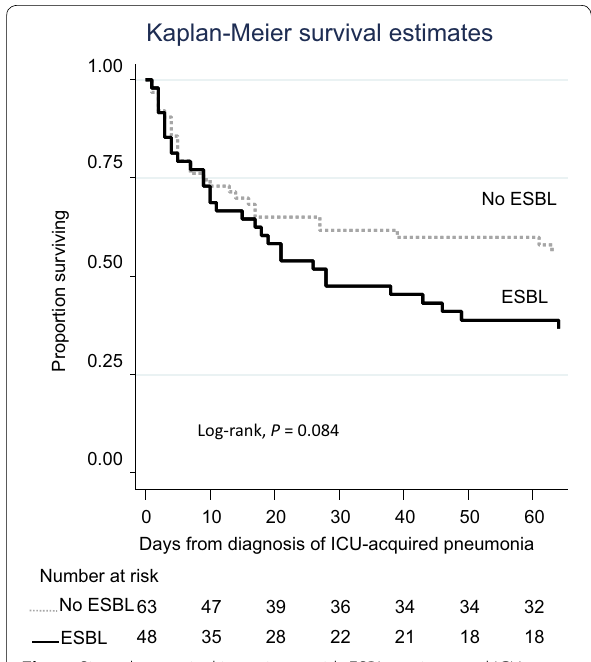
Fig. 1 Sixty‑day survival in patients with ESBL carriage and ICU‑ acquired pneumonia